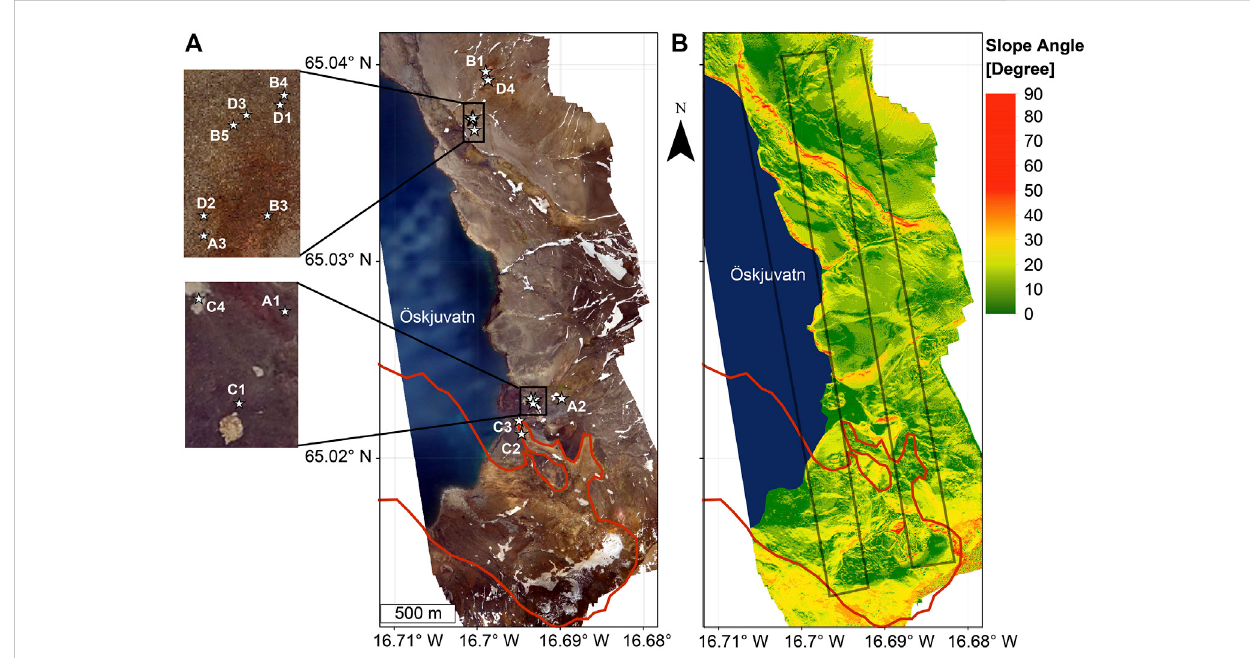
FIGURE 5 (A) Dronederived orthomosaic showing therock sample locations indicatedby whitestars and (B) slopemapofeasternAskjacaldera.The landslide outline is illustrated as a red polygon. The fl ight path is sketched in black lines in (B)